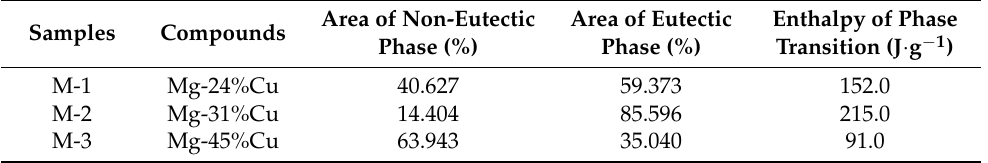
Table 3. The phase transformation enthalpy and eutectic area of samples.